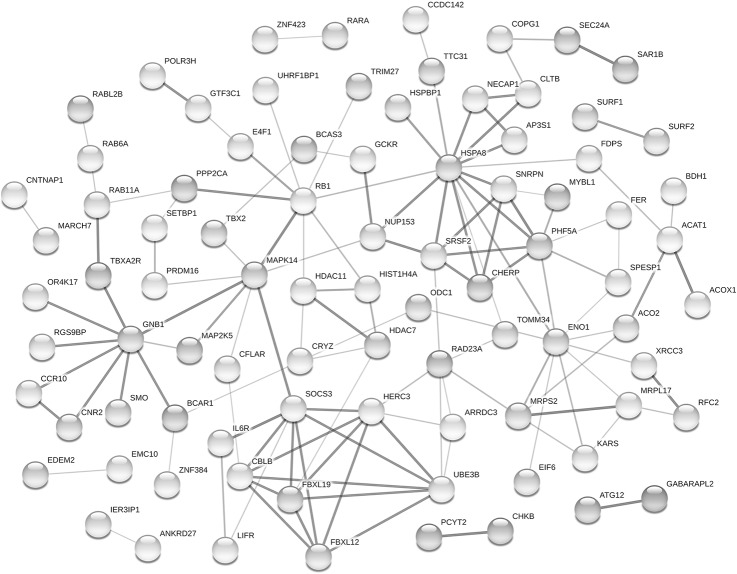
The STRING network representing known gene-gene interactions for 172 genes differentially methylated in the IC group.The nodes represent genes; only connected nodes are shown (k = 87). The color saturation of edges corresponds to the confidence score of the functional association; medium (> .400) and high (> .700) scores are denoted by light grey and dark grey, respectively.